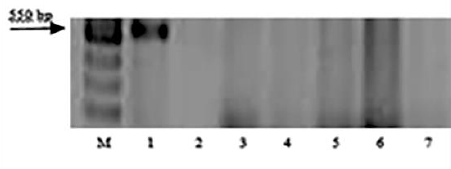
Figure 2. Amplification products of SCAR marker SCS5 550 linked to leaf rust resistance gene Lr9 : M — 100 bp DNA Ladder; 1 — Thatcher Lr 9; 2 — k-62492 T. boeoticum ; 3 — k-66369 T. boeoticum ; 4 — k-64777 T. urartu ; 5 — k-64782 T. urartu ; 6 — k-64783 T. urartu ; and 7 — k-66372 T. araraticum.